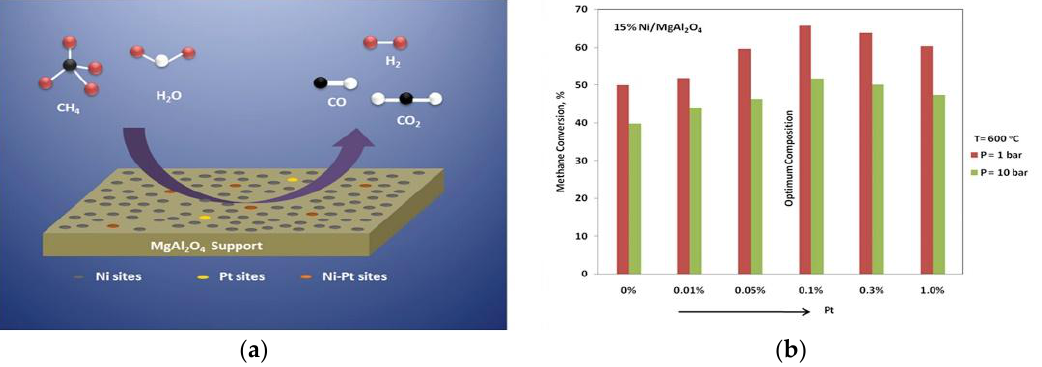
Figure 8. Schematic representation of Ni-Pt/MgAl2O4 bimetallic system ( a ), and the optimum catalytic performance in SRM ( b ).